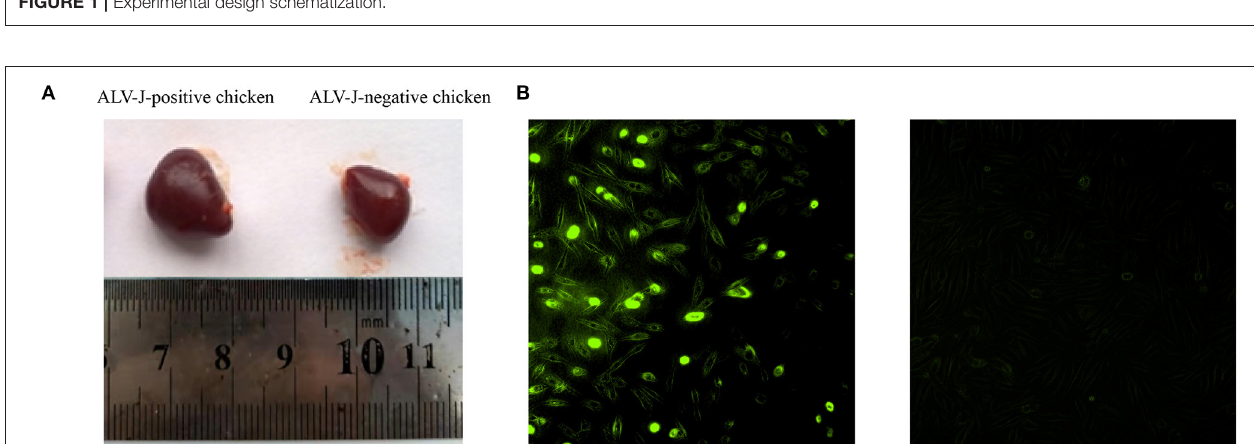
FIGURE 2 | Characteristics of avian leukosis virus subgroup J (ALV-J)-negative and ALV-J-positive chicken samples. (A) Spleens of ALV-J-positive (left) and ALV-J-negative chickens (right); (B) immunofluorescence showed positive green fluorescence signals in DF-1 cells inoculated with liver homogenate of ALV-J-positive chickens (left) and no fluorescent signals in DF-1 cells inoculated with liver homogenate of ALV-J-negative chickens (right).